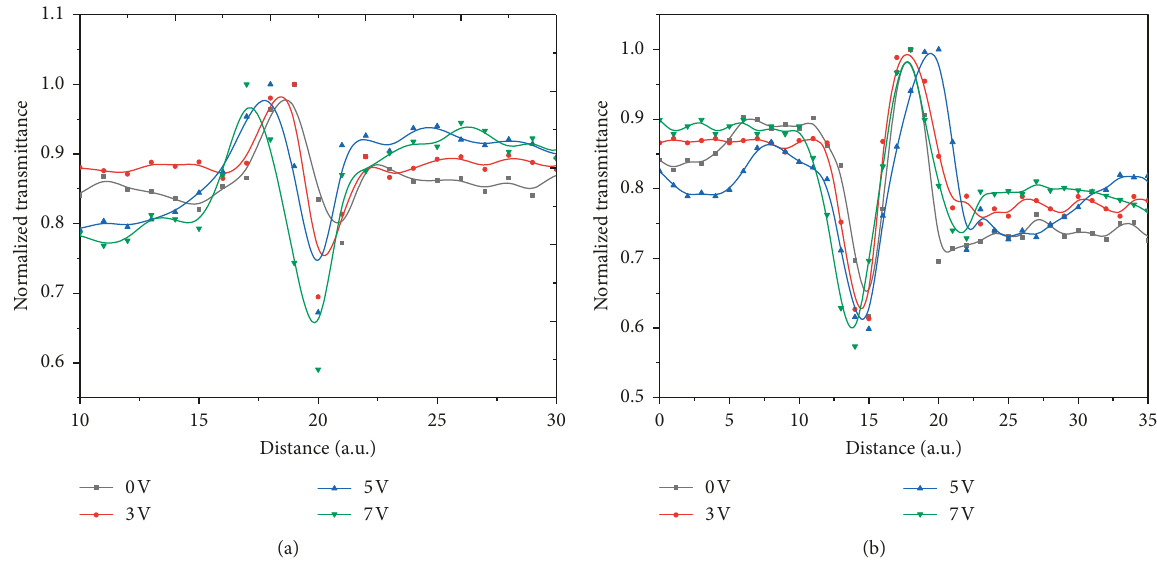
Figure 9: Transmittance with closed-aperture Z-scan of the effects of the external electric